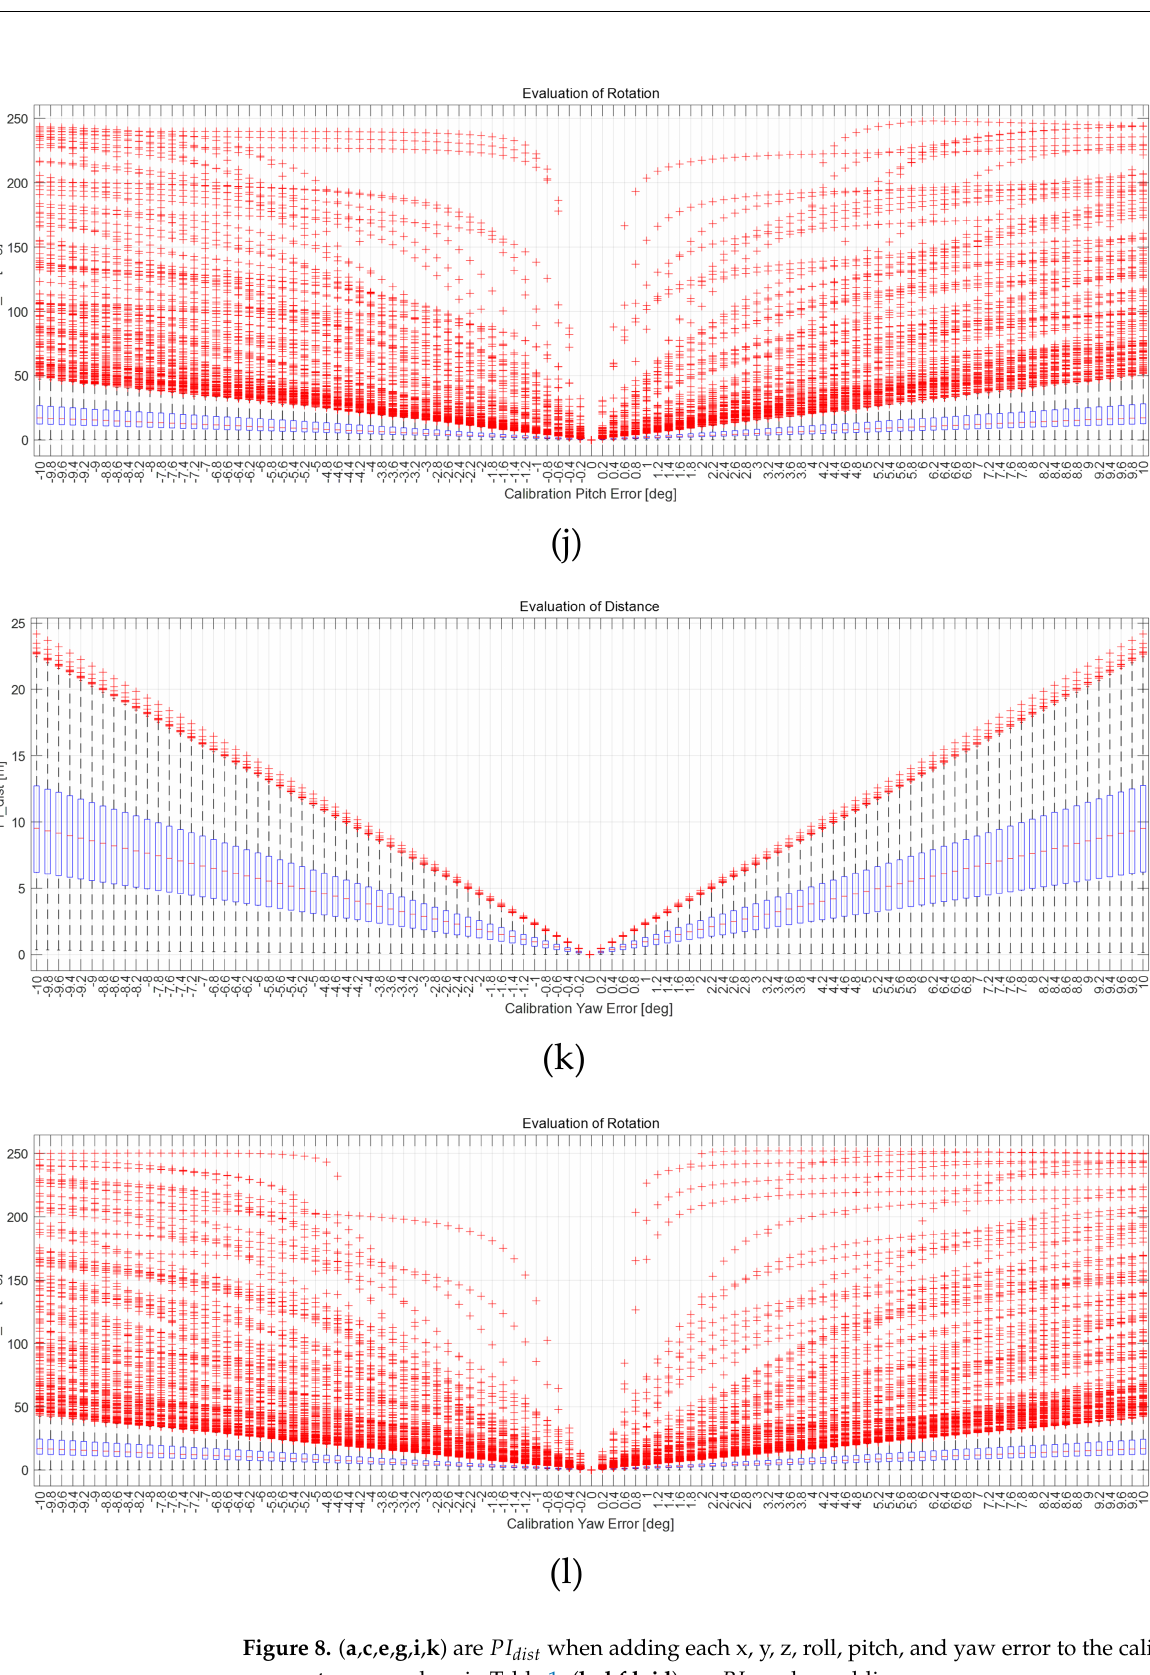
Figure 8. ( a , c , e , g , i , k ) are PI dist when adding each x, y, z, roll, pitch, and yaw error to the calibration parameter as much as in Table 1. ( b , d , f , h , j , l ) are PI rot when adding